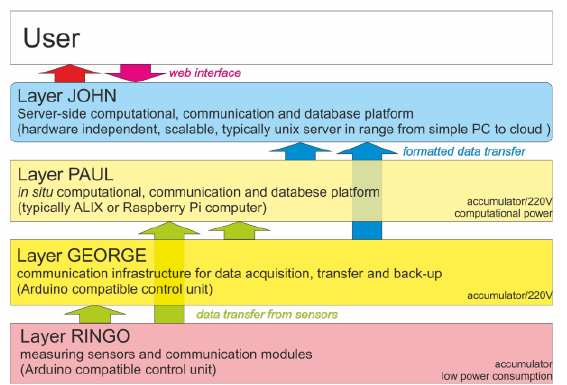
Figure 1. Schematic depiction of device hierarchy ordered from bottom to top according to increasing data acquiring and processing capabilities and also energy